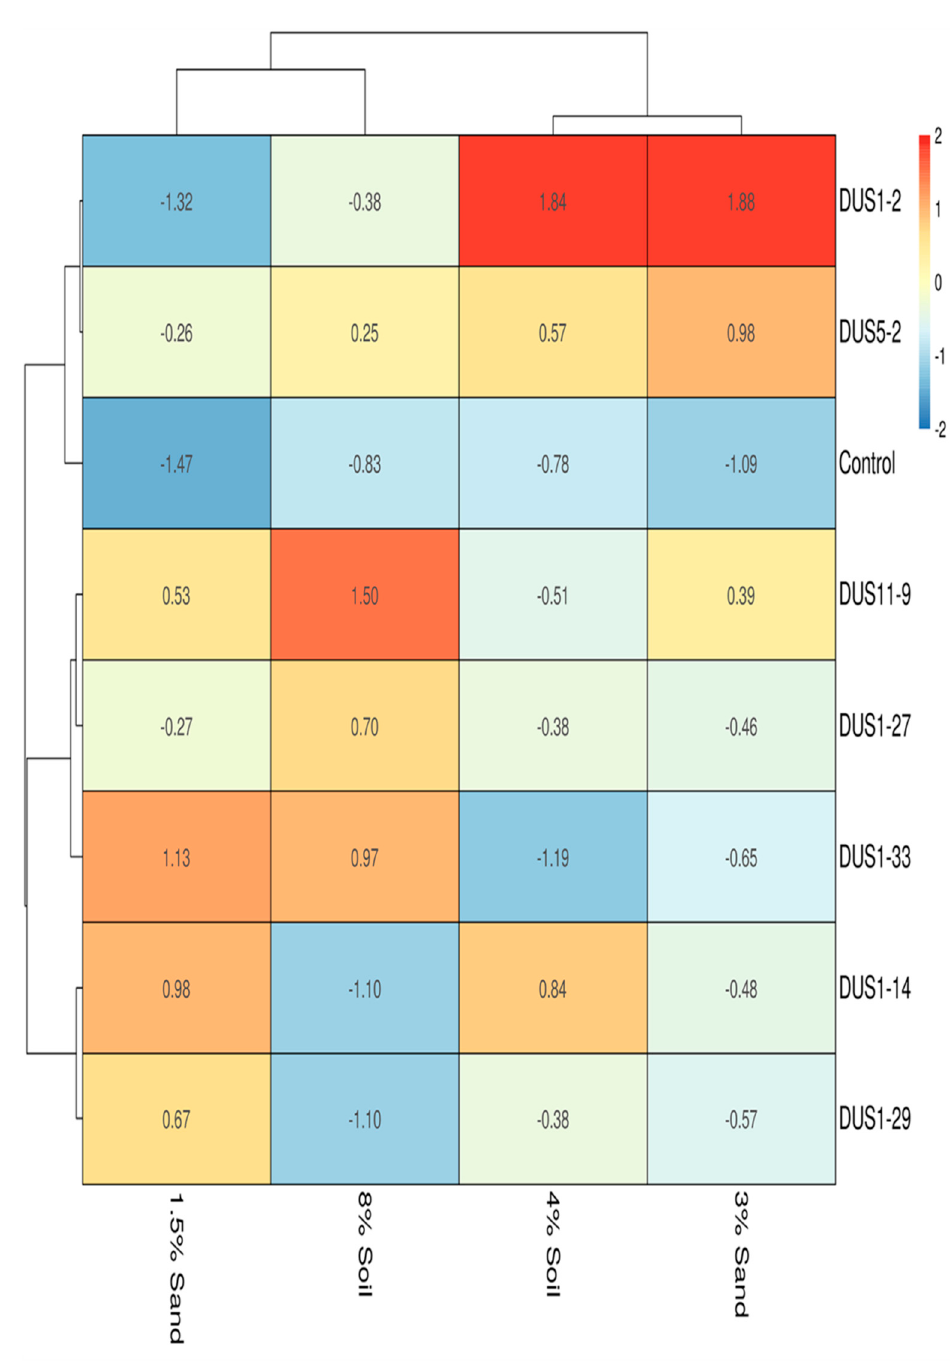
Figure 7. Total plant dry biomass for plants grown in either sand-based systems with 3% water activity (3% sand), sand-based system with 1.5% water activity (1.5% sand), soil-based system and 8% water activity (8% soil) or soil-based system with 4% water activity (4% soil). The ranking is based on PCA analysis where total dry plant biomass of uninoculated control plants or inoculated plants was compared across the four growth systems.